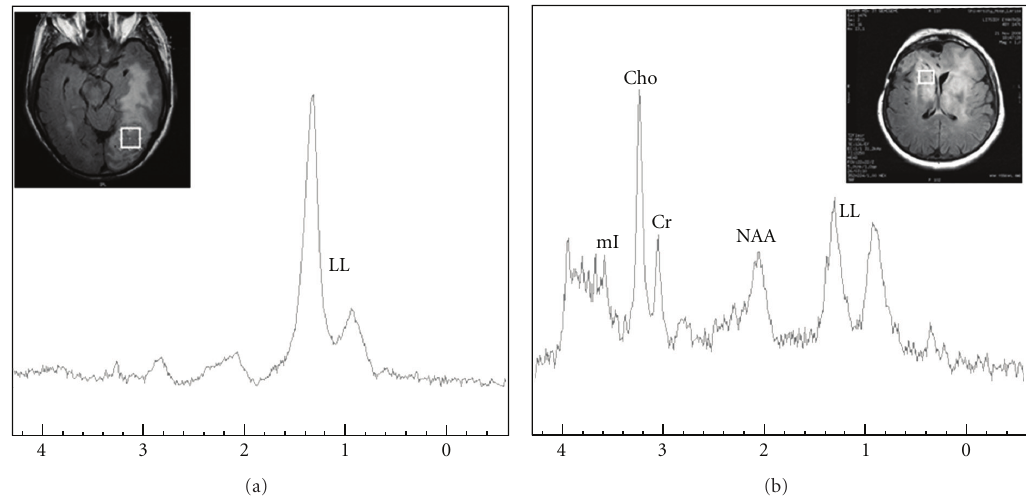
Figure 3: Short TE 1 H-MR spectra of a 66-years-old male (a) and a 51-year-old female (b) with glioblastoma multiform and anaplastic astrocytoma, respectively. Spectra illustrate high grade glioma intratumoral patterns of (a) dominant LL peak and (b) smaller LL peak with clear evidence of all the other metabolites.